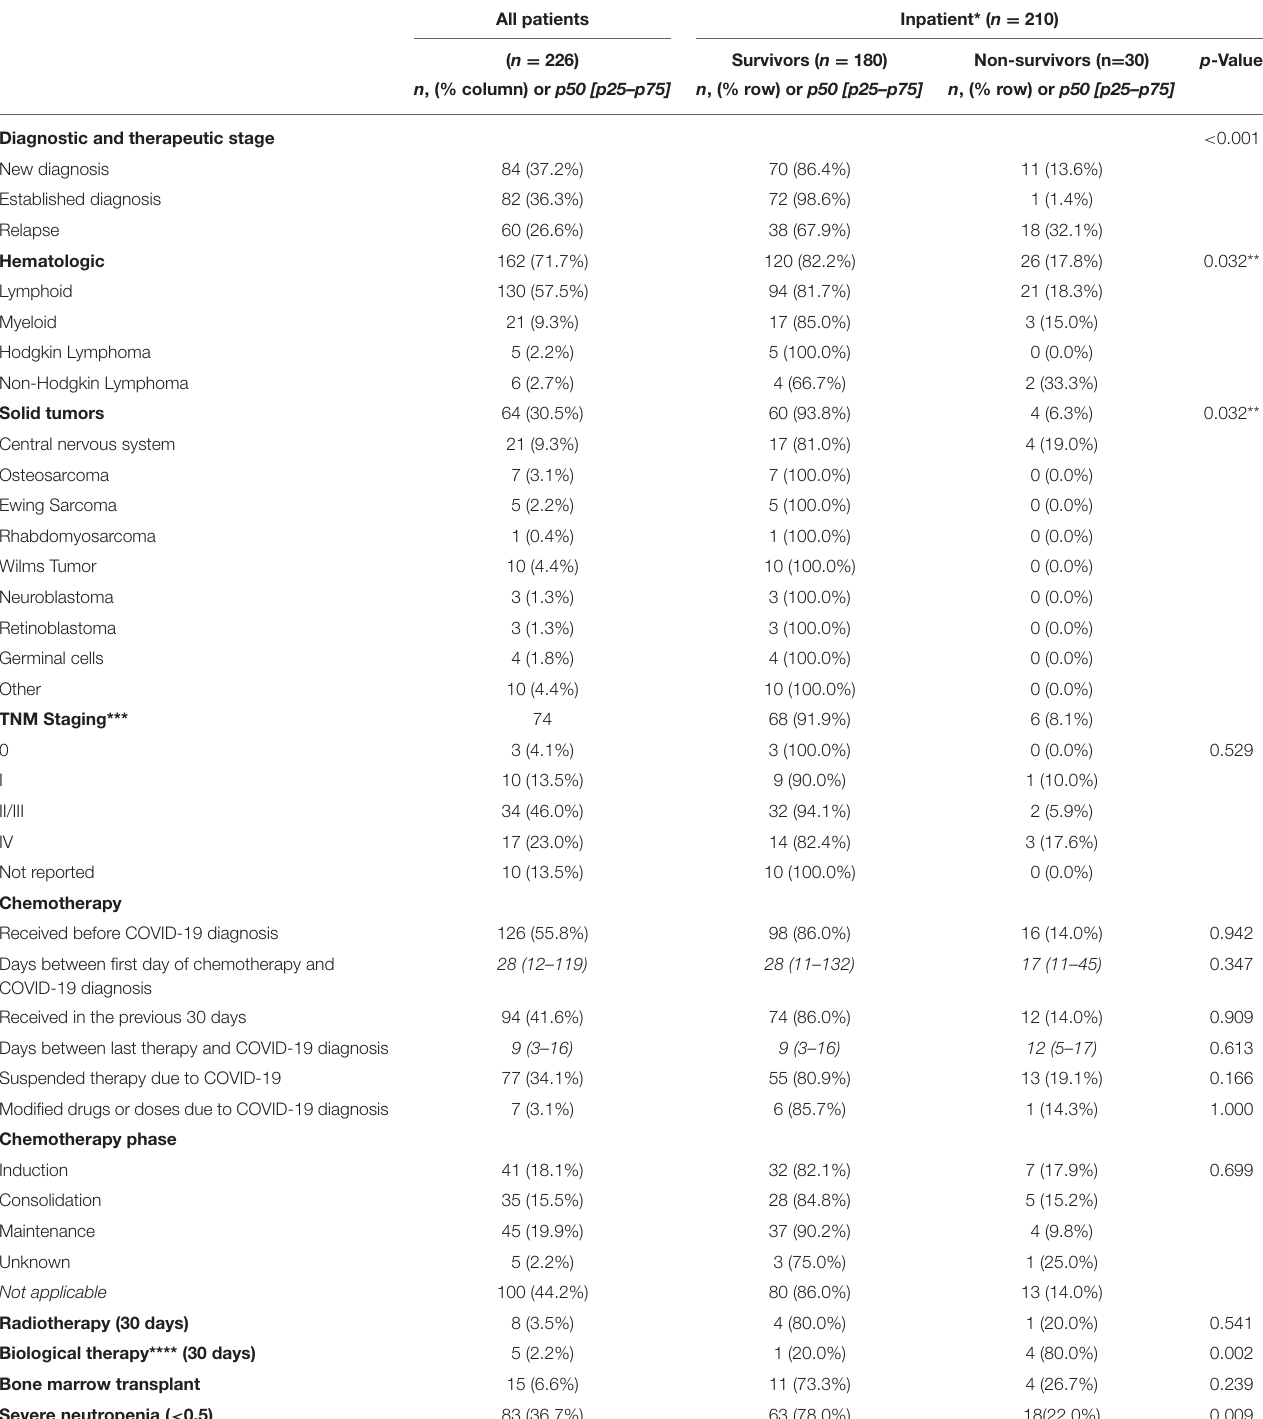
TABLE 2 | Oncological characteristics including diagnosis and oncological therapies.